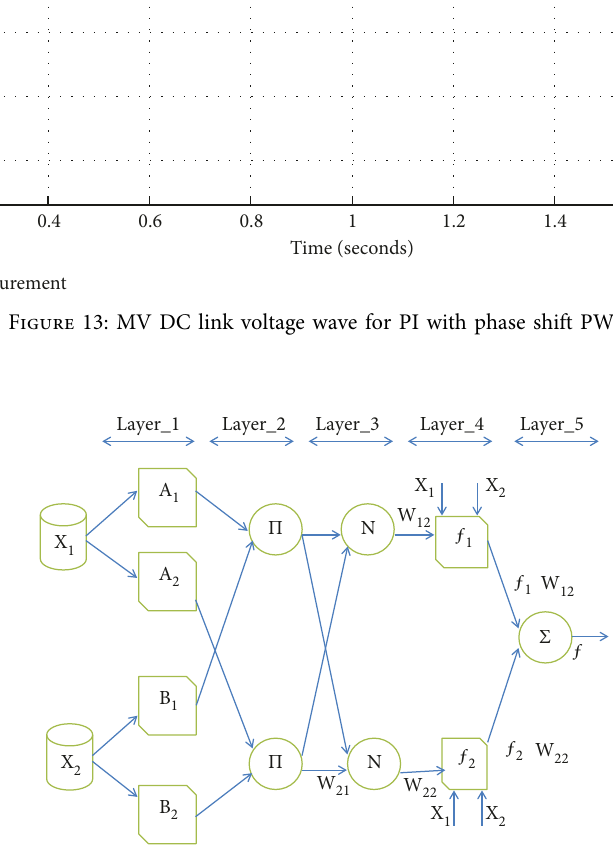
Figure 14: Basic ANFIS architecture.